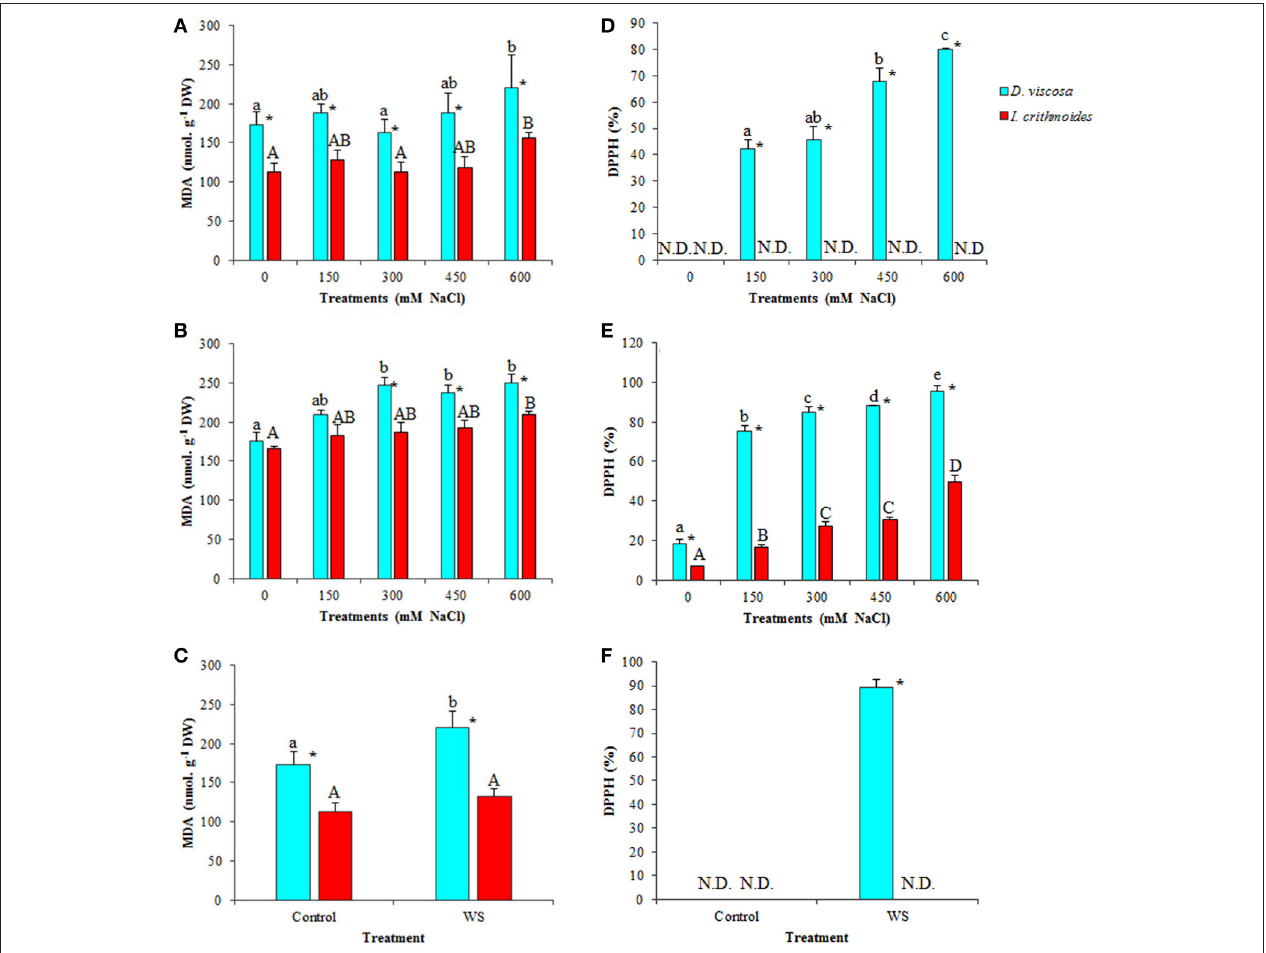
FIGURE 6 | Malondialdehyde (MDA) accumulation and DPPH scavenging activity (DPPH), in leaves of D. viscosa and I. crithmoides stressed plants. MDA (A–C) and DPPH (D–F) after 3 weeks (A,D) and 6 weeks (B,E) of treatment with the indicated NaCl concentrations, or after 3 weeks of water stress (C,F) . Values shown are means ± SD ( n = 5 ). Different letters (lowercase for D. viscosa and capital letters for I. crithmoides ) over the bars indicate significant differences between treatments for each species according to Tukey test ( α = 0.05). Asterisks ( * ) indicate significant differences between the two species for the same treatment. (N.D. stands for “not